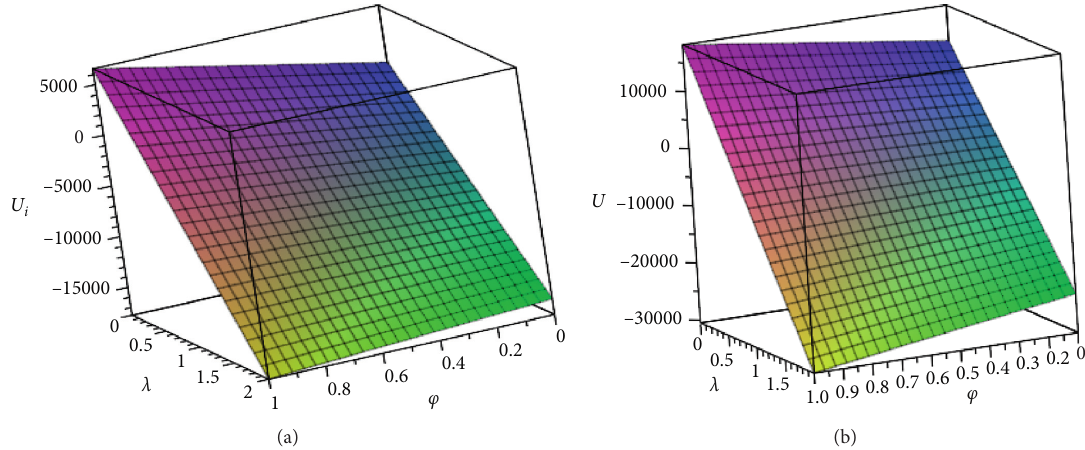
Figure 2: The impact of (a) λ and (b) φ on the utility of supply chains for manufacturers’ distributional fairness concerns under RS.